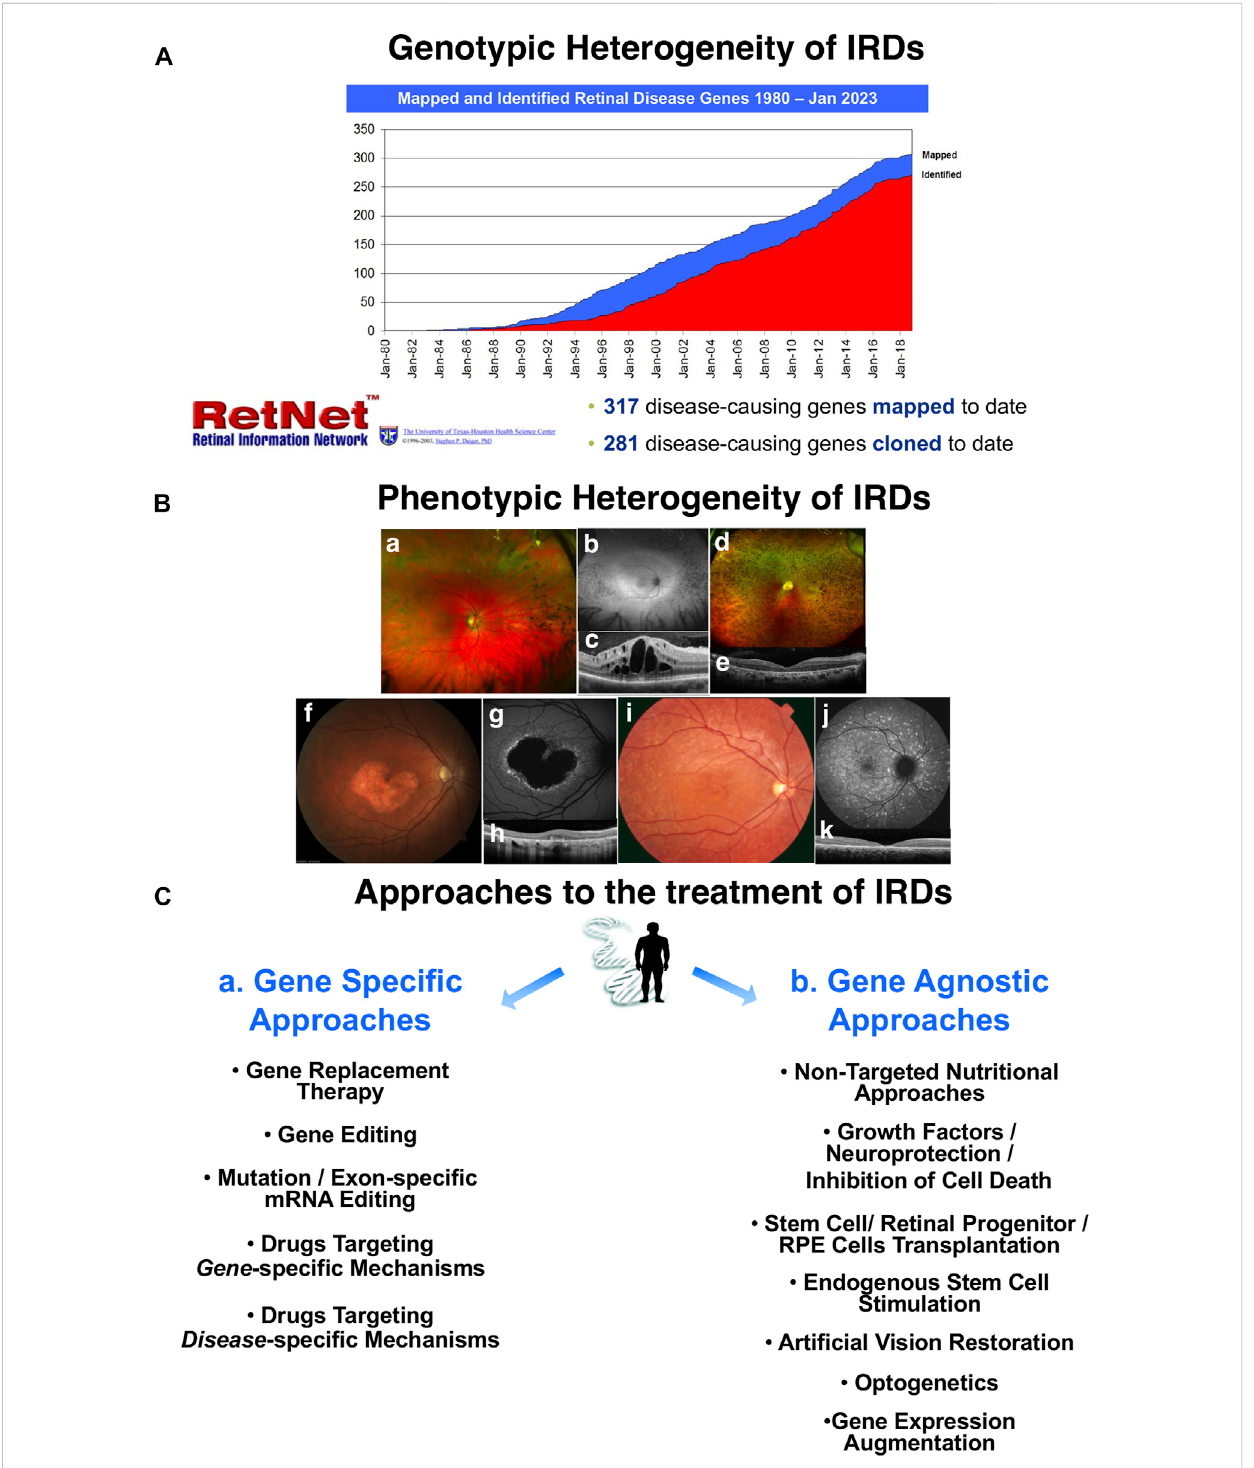
FIGURE 1 Thelandscapeoftreatmentstrategiesforinheritedretinaldegenerations(IRD). Rapidaccelerationofresearchsincethe1980shasledtothediscoveryof 317disease-causinggeneswith281ofthesegenesnowcloned,highlightinggenotypicheterogeneitypreviouslydescribedbytheRetNetproject(hosted by the University of Texas-Houston Health Science Center) (A) . The immense phenotypic heterogeneity of IRDs is further illustrated by fundus images (B, a – k) . Patients with retinitis pigmentosa (RP) can present with good central retinal preservation (a – b) with mild to moderate vision loss and good preservation of the central photoreceptors exempli fi ed by a partially detectable ellipsoid zone (EZ) and retained outer nuclear layer (ONL). However, RP can also induce signi fi cant in fl ammatory complications like cystoid macular edema (CME) (c) . In other instances of RP, the macular area may be partially compromised (d) ,withminimalcentralEZpreservation (e) .Inmacular,cone,andcone-roddystrophies, centraldisruptionsaremostcommon,butsome present with signi fi cant foveal atrophic changes and partial foveal EZ preservation (f – h) ; others present with global changes marked by central retinal thinning and complete EZ loss (J – K) . Gene-speci fi c therapy (C, a) is unlikely to bene fi t patients with severe degeneration (d – k) , but gene-agnostic strategies (C, b) may still offer these patients a path to recovering